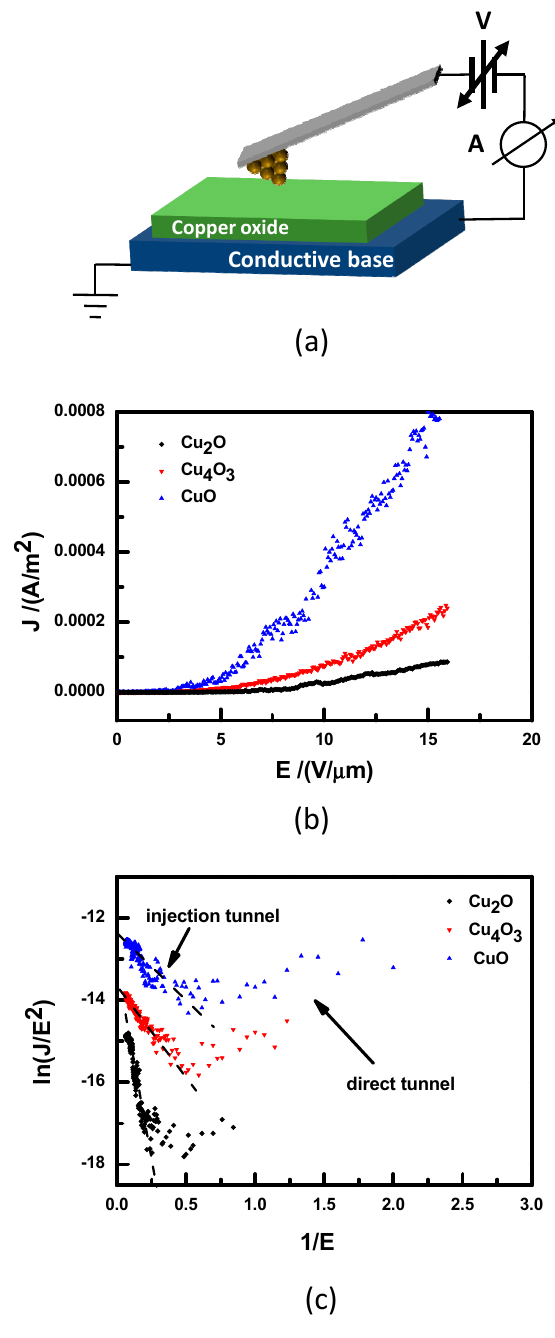
Figure 7. ( a ) A sketch of the C-AFM measurement system; ( b ) J–E curves of field emission; ( c ) ln( J/E 2 ) versus 1/ E plots of samples 1–4.